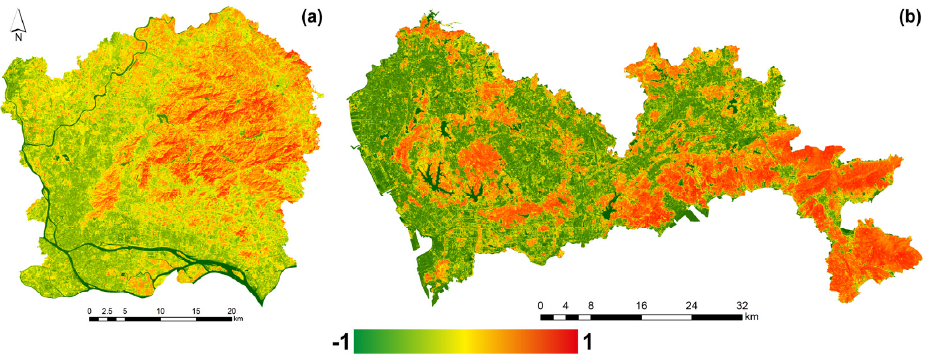
Figure 5. The EVI for ( a ) Guangzhou central urban district and ( b ) Shenzhen.